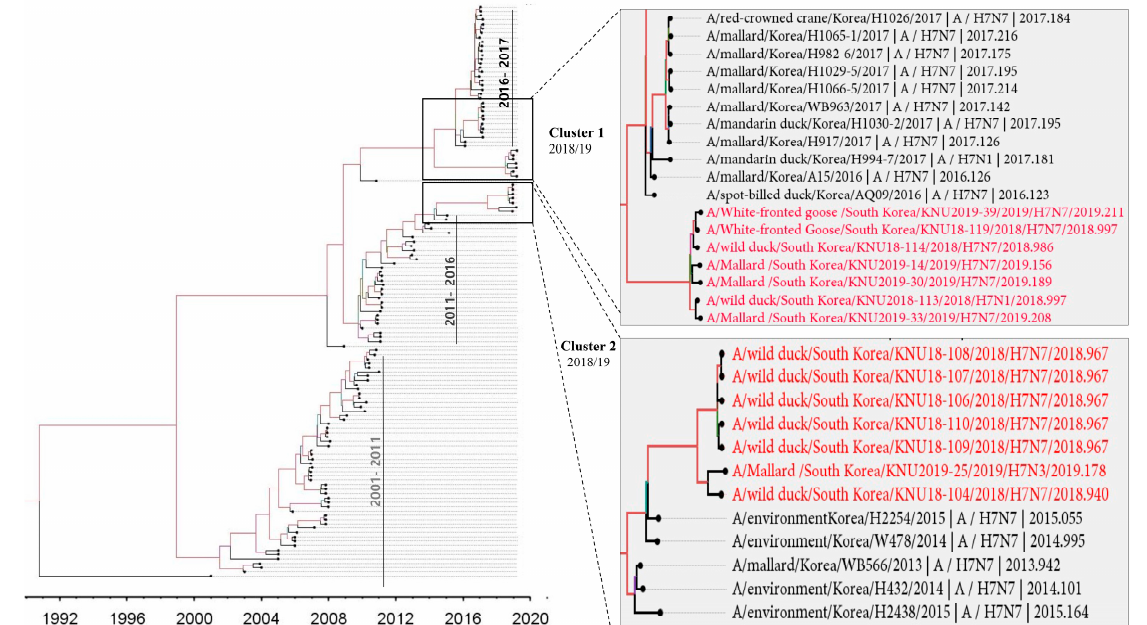
Figure 2. The SRD06 partitioned-substitution model, an uncorrelated lognormal relaxed clock, and a Bayesian skyline coalescent model in BEAST v1.10.4 were used to estimate the time-scaled maximum clade credibility (MCC) phylogeny for all HA sequences isolated between